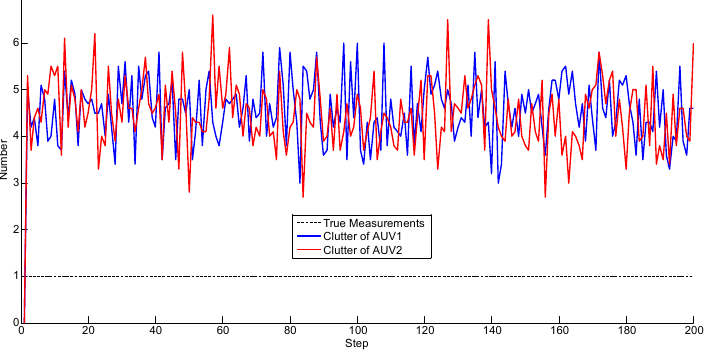
Figure 12. Number of the clutter